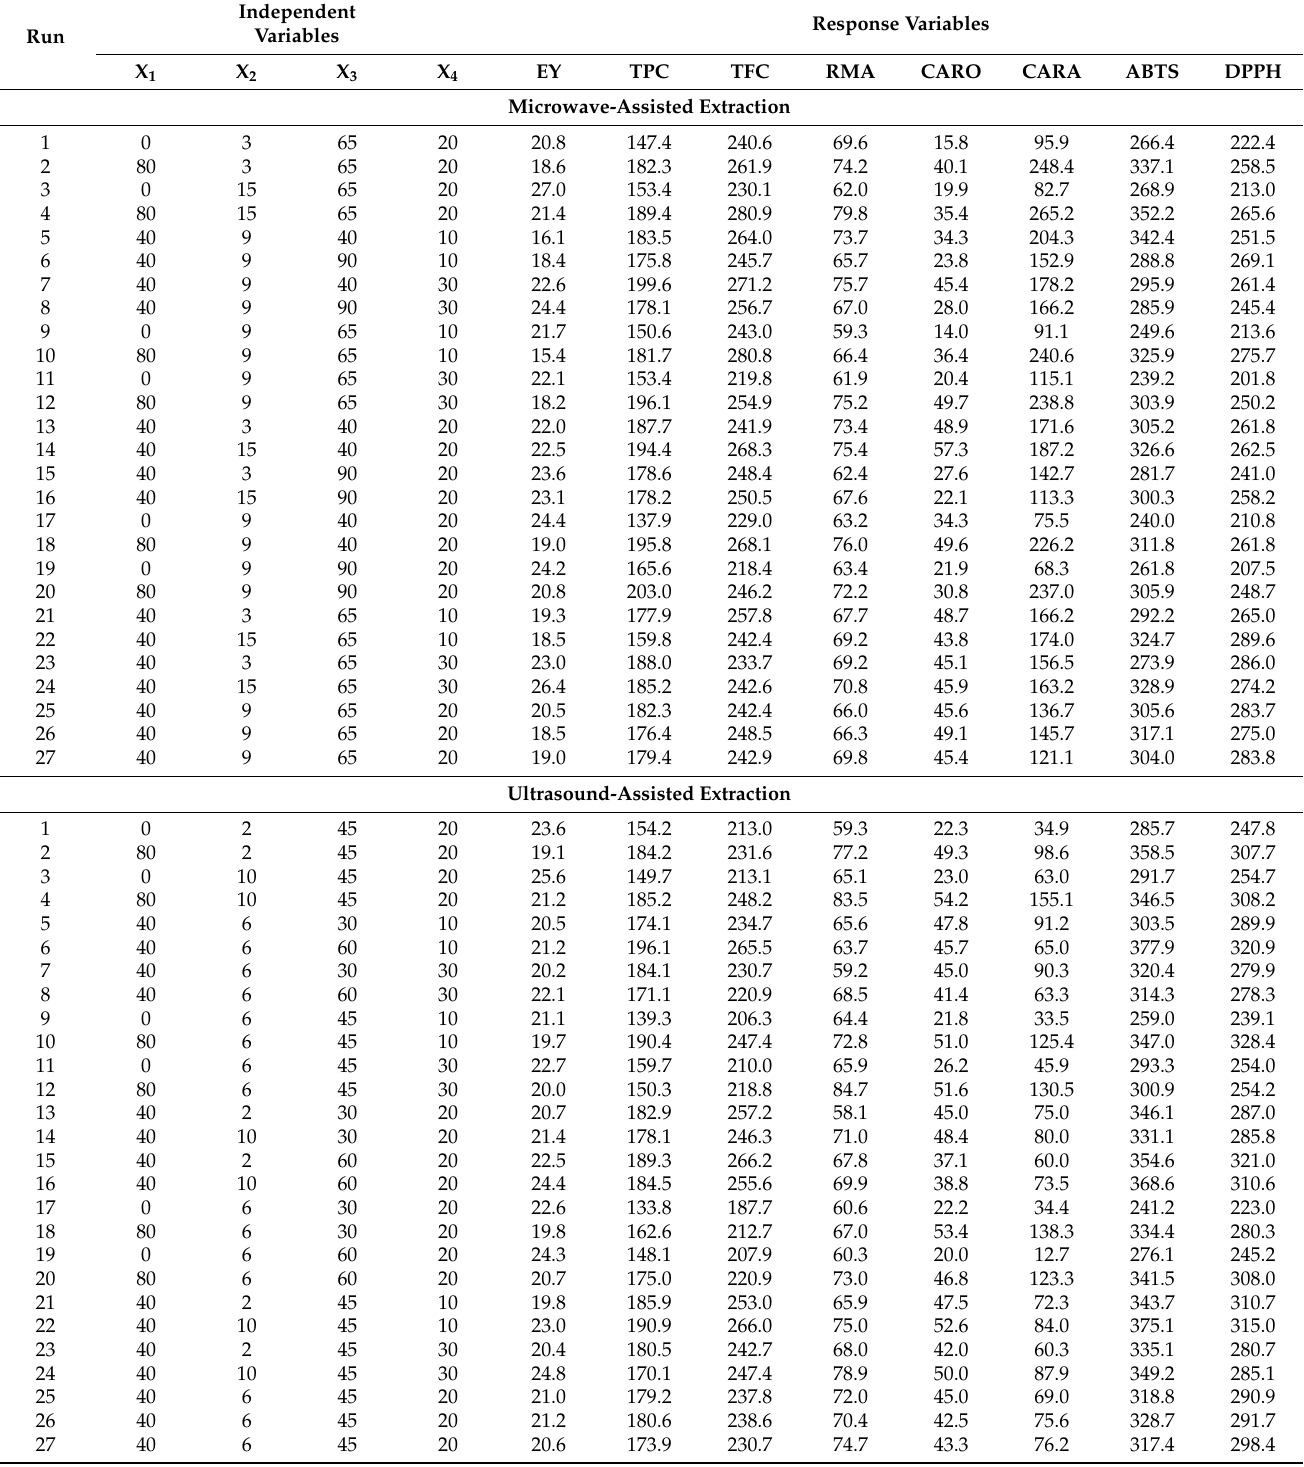
Table 2. Box–Behnken experimental design with the observed responses for the microwave-assisted extraction (MAE) and ultrasound-assisted extraction (UAE) from sage solid